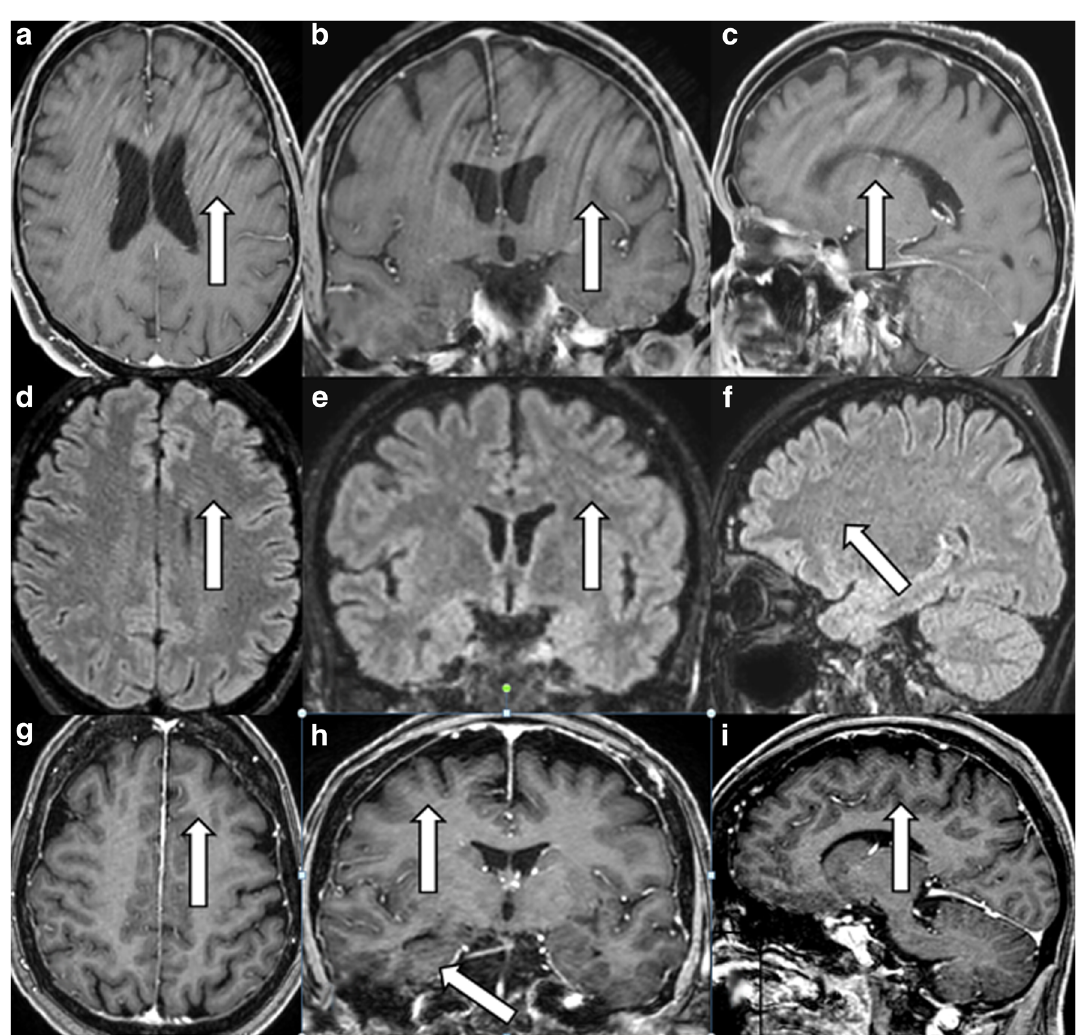
Fig. 3 The streaky linear artefact type A. Streaky artefacts type A ( white arrows ) on postcontrast 3D T1 m-Dixon TFE (F a - c ) and on 3D FLAIR ( d - f ) and on 3D T1 TFE postcontrast sequence ( g - i ). The streaks are horizontal or oblique, long or short lines, most obvious on